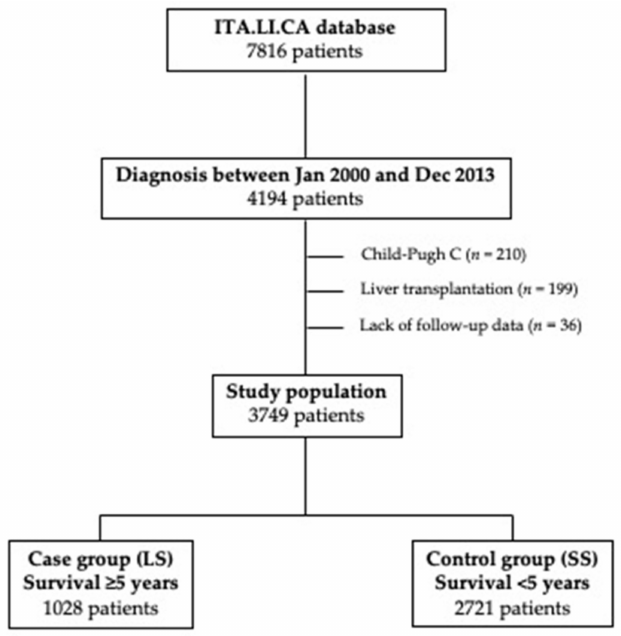
Figure 1. Study flow chart. Selection of patients finally included in the case (long-term survivors—LS) and control (short-term survivors—SS)